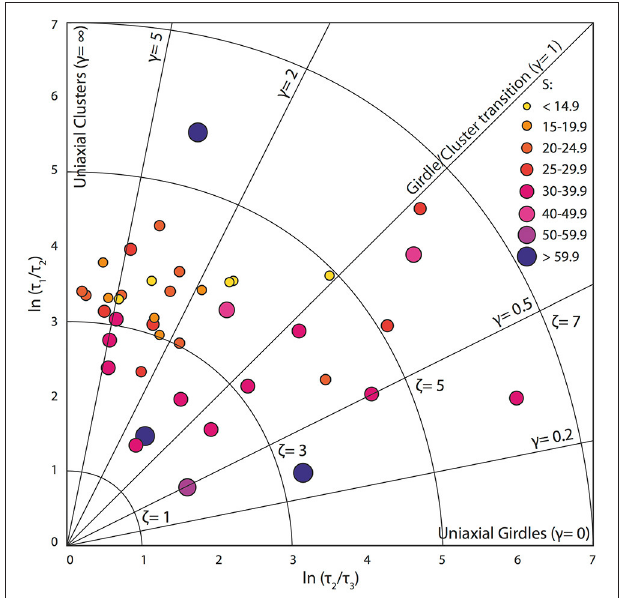
FIGURE 11 | Woodcock (1977) diagram. Shape and strength of the VGP distributions plotted as ln ( τ 1 / τ 3 ) vs. ln ( τ 2 / τ 3 ), as a function of VGP scatter S. See text for details.